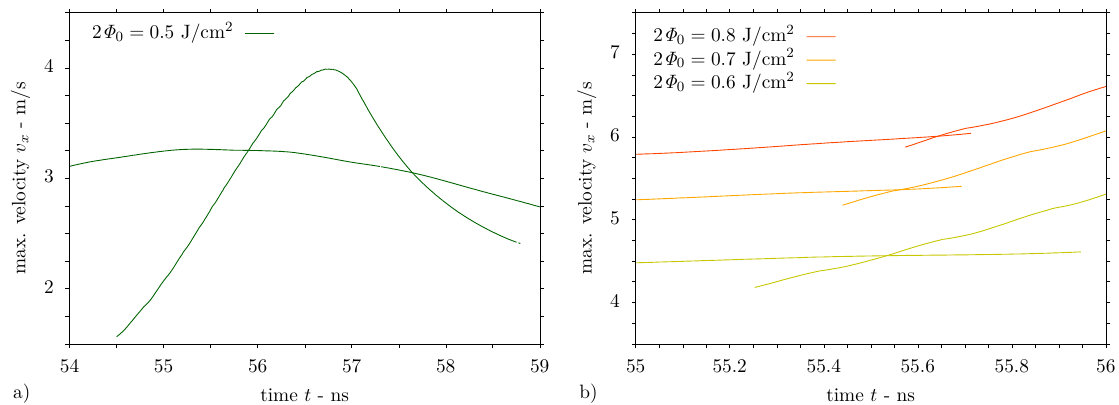
Figure 7. Occurrence of second extremum of horizontal velocity below the surface closer to the centre of the melt pool during DLIP of AISI 304 stainless steel substrate: ( a ) Coexistence of outer (permanent) and inner extrema for moderate fluence. ( b ) Onset and persistence of inner extrema for higher fluences.